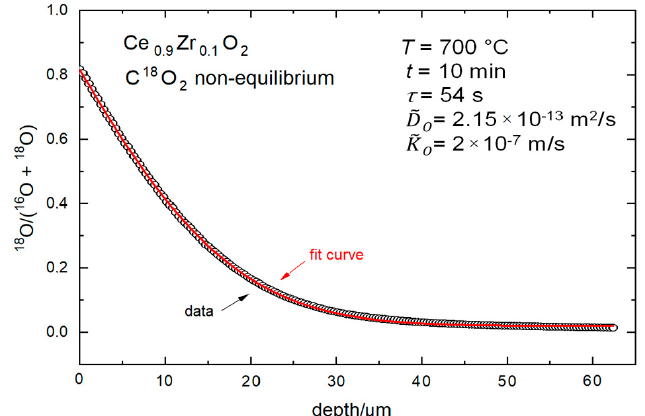
Figure 3. SIMS line-scan depth profile for the 18 O distribution of a 10 at-% Zr-doped ceria sample after an oxygen isotope exchange from C 18 O 2 (Ar/C 18 O 2 gas mixture) in non-equilibrium conditions at T = 700 ◦ C. The oxygen isotope fraction is shown in comparison with the fit by Equation (3), together with the simultaneous determined non-equilibrium (chemical) values (cid:101) D O and (cid:101) K O